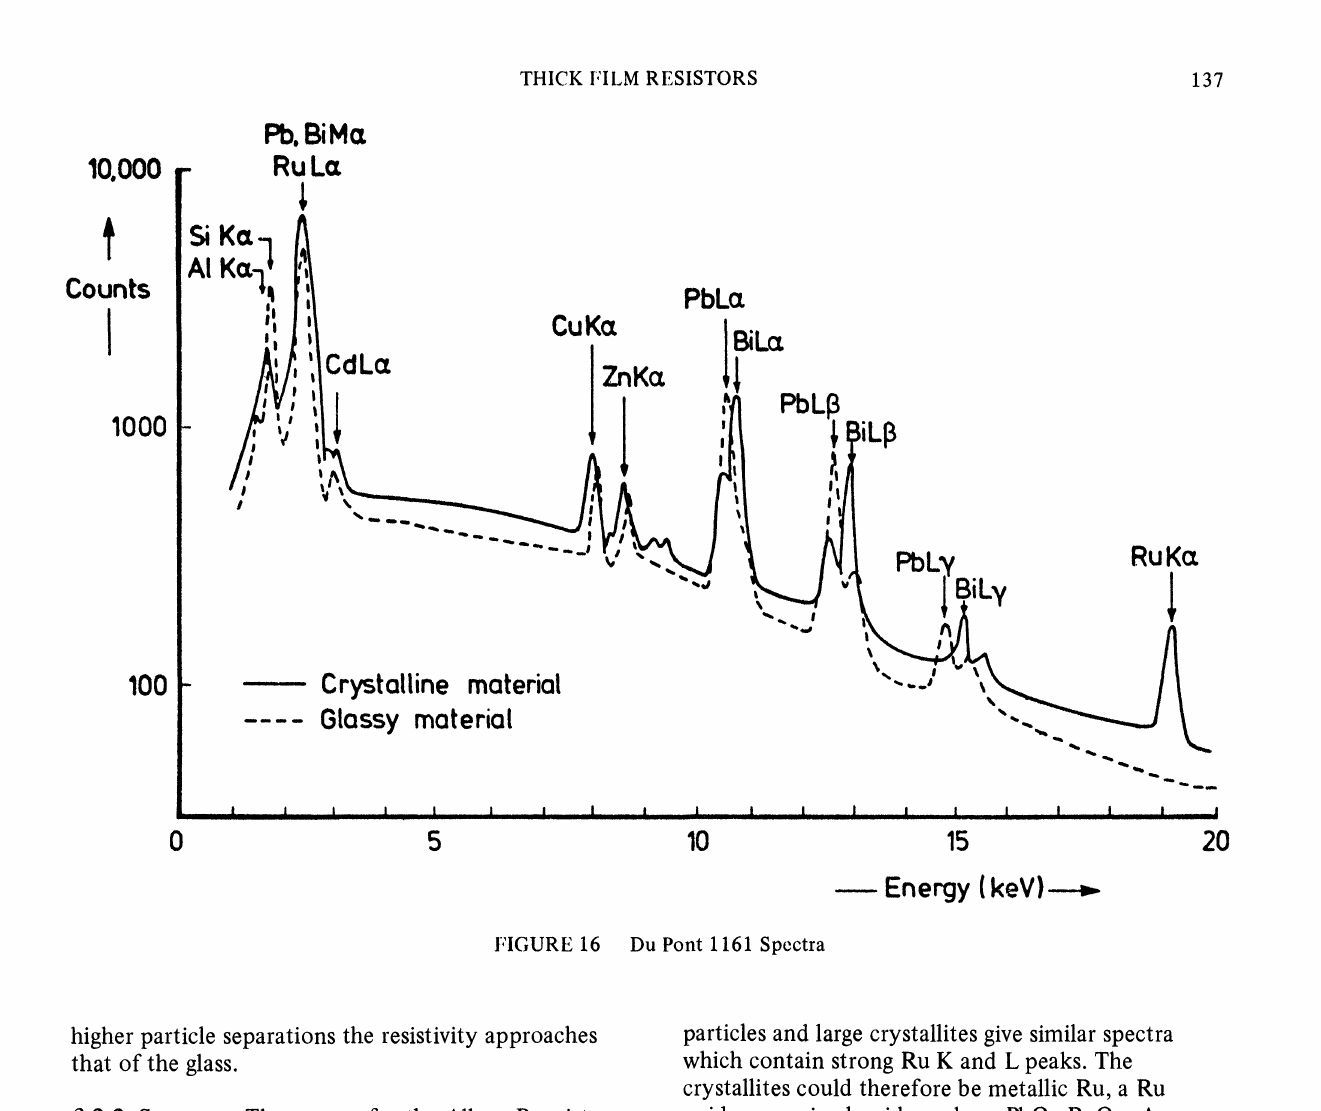
FIGURE 16 Du Pont 1161